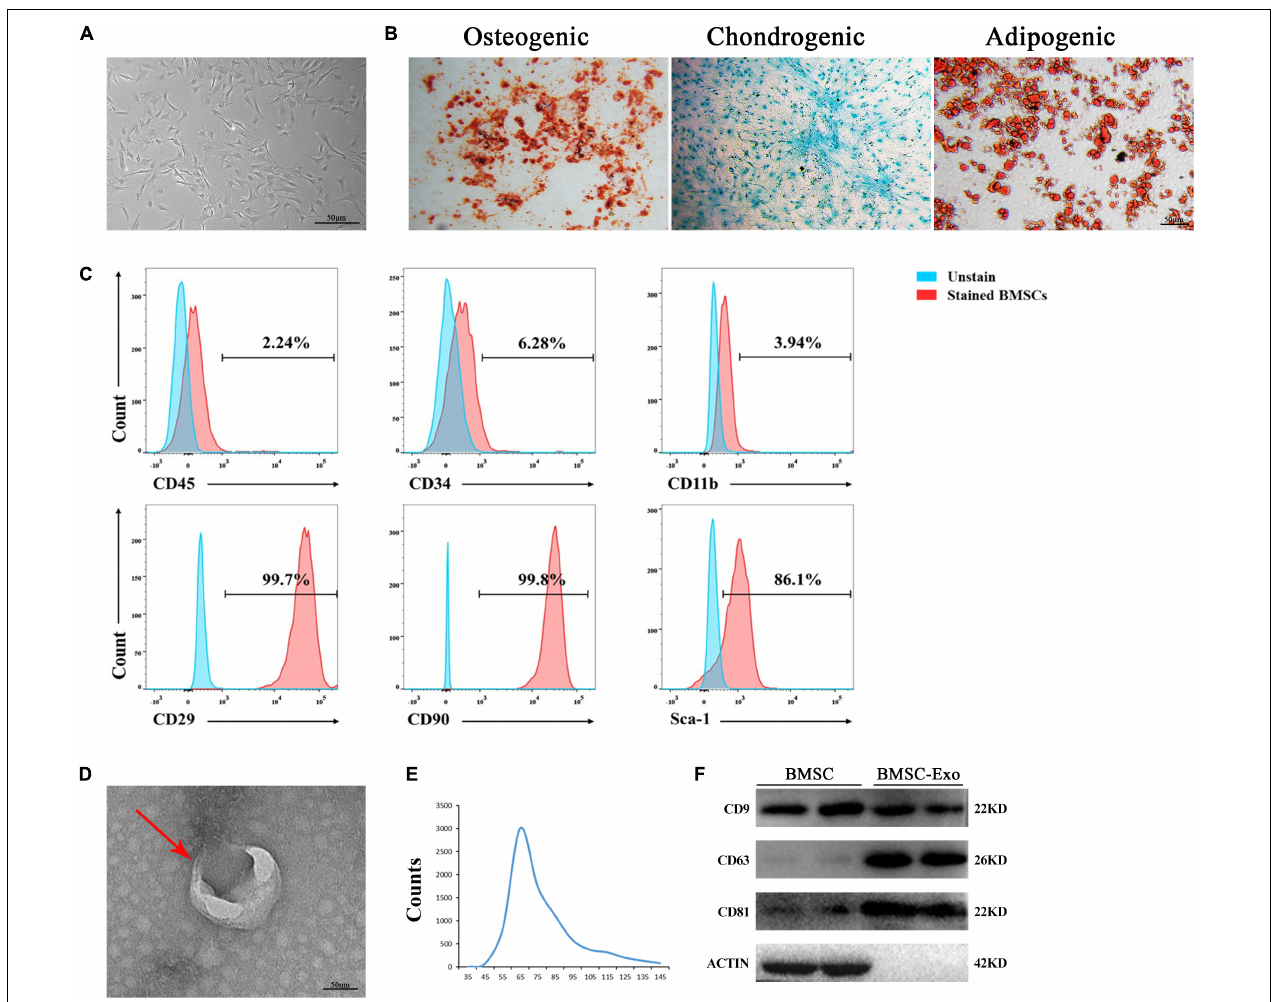
FIGURE 1 | Morphology and characterization of BMSCs and BMSC-derived exosomes. (A) Representative microscopic image of BMSCs. Scale bar: 50 µ m. (B) BMSCs demonstrated osteogenic, chondrogenic, and audiogenic pluripotent differentiation abilities. Scale bar: 50 µ m. (C) Flow cytometry analysis of cell surface markers on BMSCs. (D) Transmission electron microscopy (TEM) image of BMSC-derived exosomes. Scale bar: 50 nm. (E) NanoSight tracking analysis (NTA) showed that the average diameters of exosomes ranged from 30 to 150 nm. (F) Western blot analysis of Tsg101 CD9, CD63, and actin.